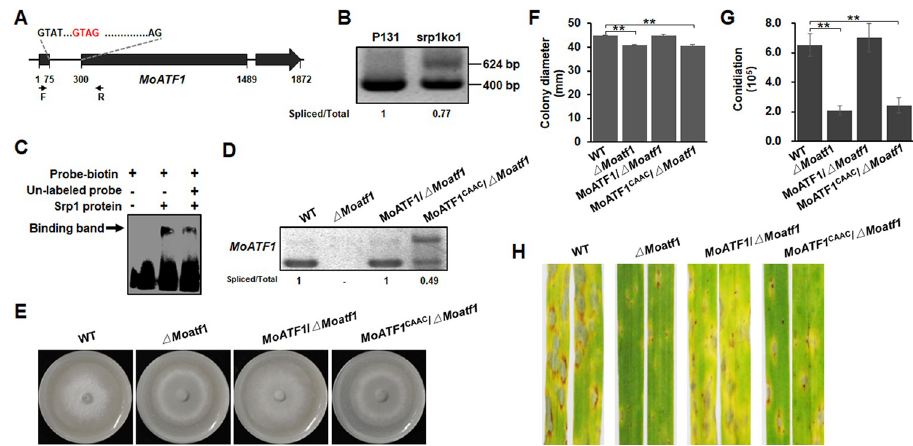
Fig 7. MoSrp1 enhances the intron splicing efficiency of a virulence gene MoATF1 . (A) Position of the 5’-GUAG-3’ motif in the MoATF1 pre-mRNA. (B) RT-PCR analysis showing splicing efficiency of the first intron of MoATF1 in the Δ Mosrp1 mutant srp1ko1 as compared with the wild-type P131. The ratio between the spliced and the total introns was shown at the bottom of each line. (C) RNA-EMSA assay showing the binding strength between MoSrp1 and the 5’-GUAG-3’ consensus in the first intron of MoATF1 . (D) RT-PCR analysis showing splicing efficiency of MoATF1 or MoATF1 CAAC in strains wild-type (WT) Guy11, Δ Moatf1 , MoATF1 / Δ Moatf1 , and MoATF1 CAAC / Δ Moatf1 (mutation of 5’-GUAG-3’ to 5’-CAAC-3’ in MoATF1 transcript). Guy11 was used as the wild-type strain to generate the Δ Moatf1 mutant. The ratio between the spliced and the total introns was shown at the bottom of each line. (E) Colony formed by strains WT, Δ Moatf1 , MoATF1 / Δ Moatf1 , and MoATF1 CAAC / Δ Moatf1 on OTA plates at 5 dpi. (F) Statistics on colony diameters of strains WT, Δ Moatf1 , MoATF1 / Δ Moatf1 , and MoATF1 CAAC / Δ Moatf1 . (G) Conidia per petri dish produced by strains WT, Δ Moatf1 , MoATF1 / Δ Moatf1 , and MoATF1 CAAC / Δ Moatf1 on OTA plates. The means and standard deviations in (F and G) were calculated based on three independent experiments each with three plates measured. Asterisk marks a significant difference between the Guy11 and mutant strains using t -test (p < 0.05). (H) Representative disease lesions on leaves of susceptible barley sprayed with conidia of strains WT, Δ Moatf1 , MoATF1 / Δ Moatf1 , and MoATF1 CAAC / Δ Moatf1 .